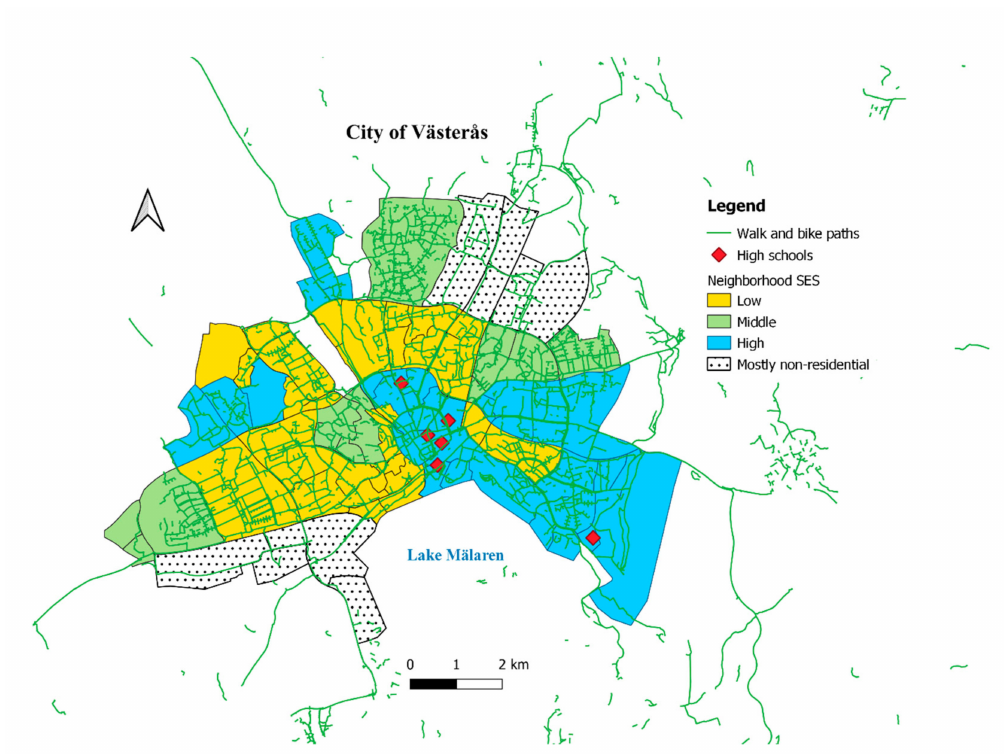
Figure 1. Socioeconomic status of neighborhoods, walk and bike paths in the municipality of Västerås and location of upper secondary schools included in the NESLA